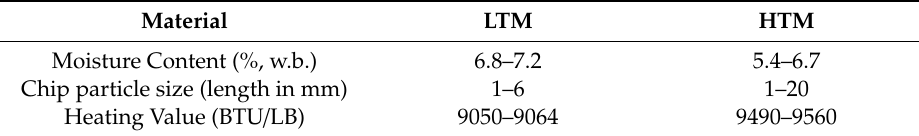
Table 1. Characterization of feed materials.